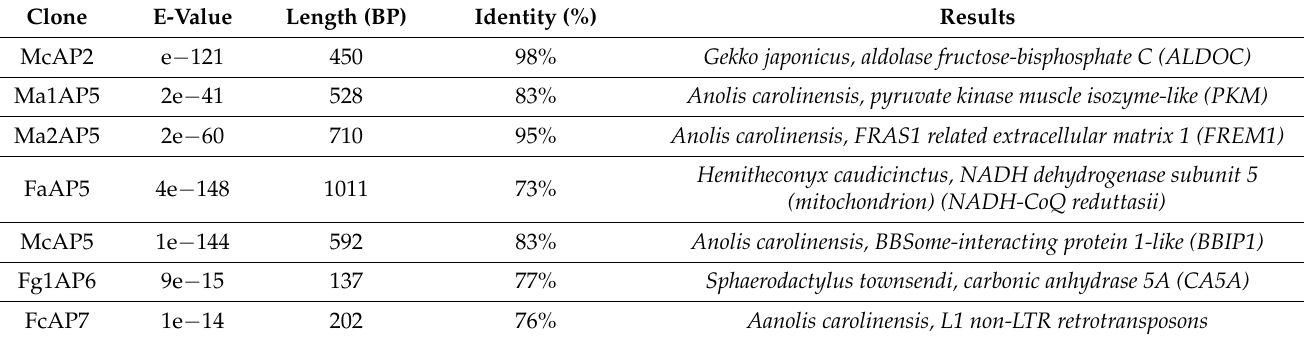
Table 4. Summary of the differentially expressed genes in E. macularius embryo at stage 30, listed according to the two different methodologies used. MPT stands for genes more expressed at a male- producing temperature and FPT stands for genes more expressed at a female-producing